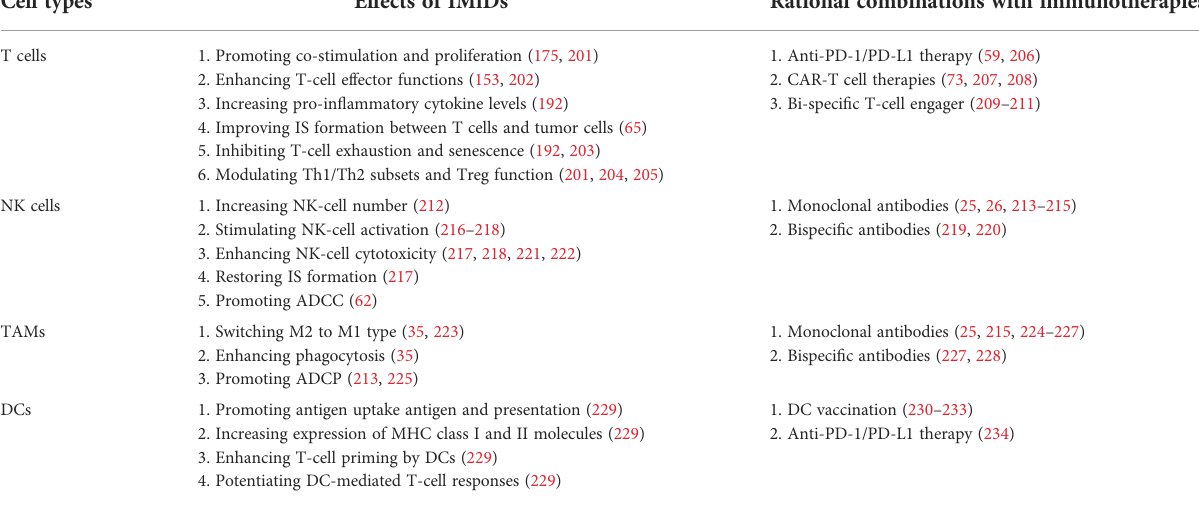
TABLE 2 Modulatory effects of IMiDs on immune cells and implications for improving